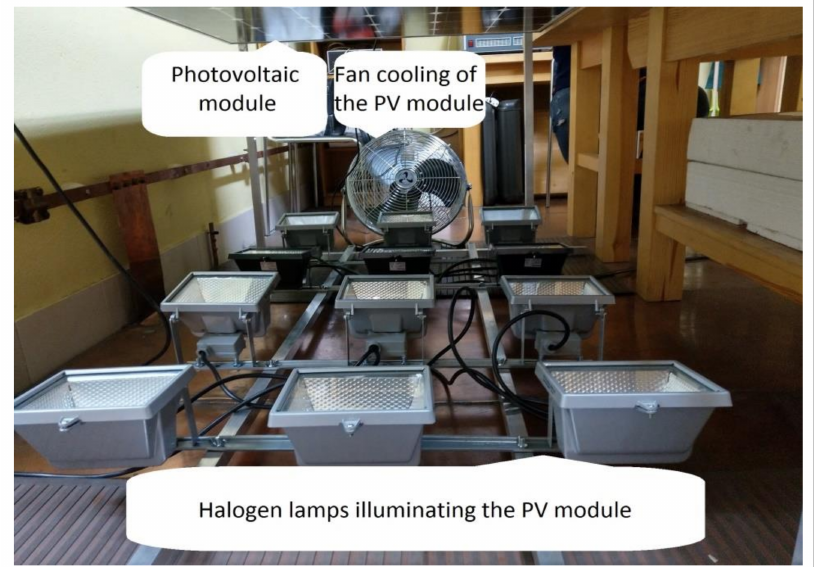
Figure 14. First part of the test stand consisting of a photovoltaic module, halogen lighting, and a cooling system.